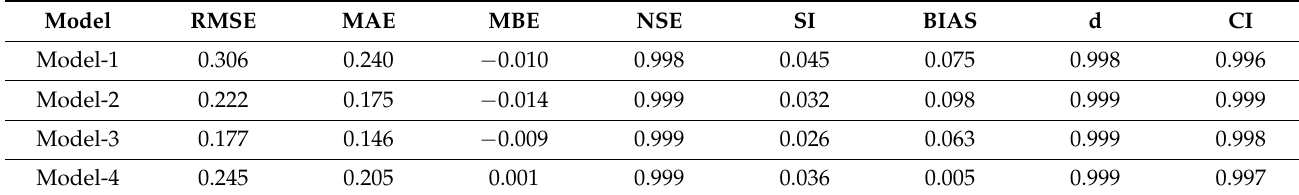
Table 5. Statistical indicators values using PNN method during testing period.